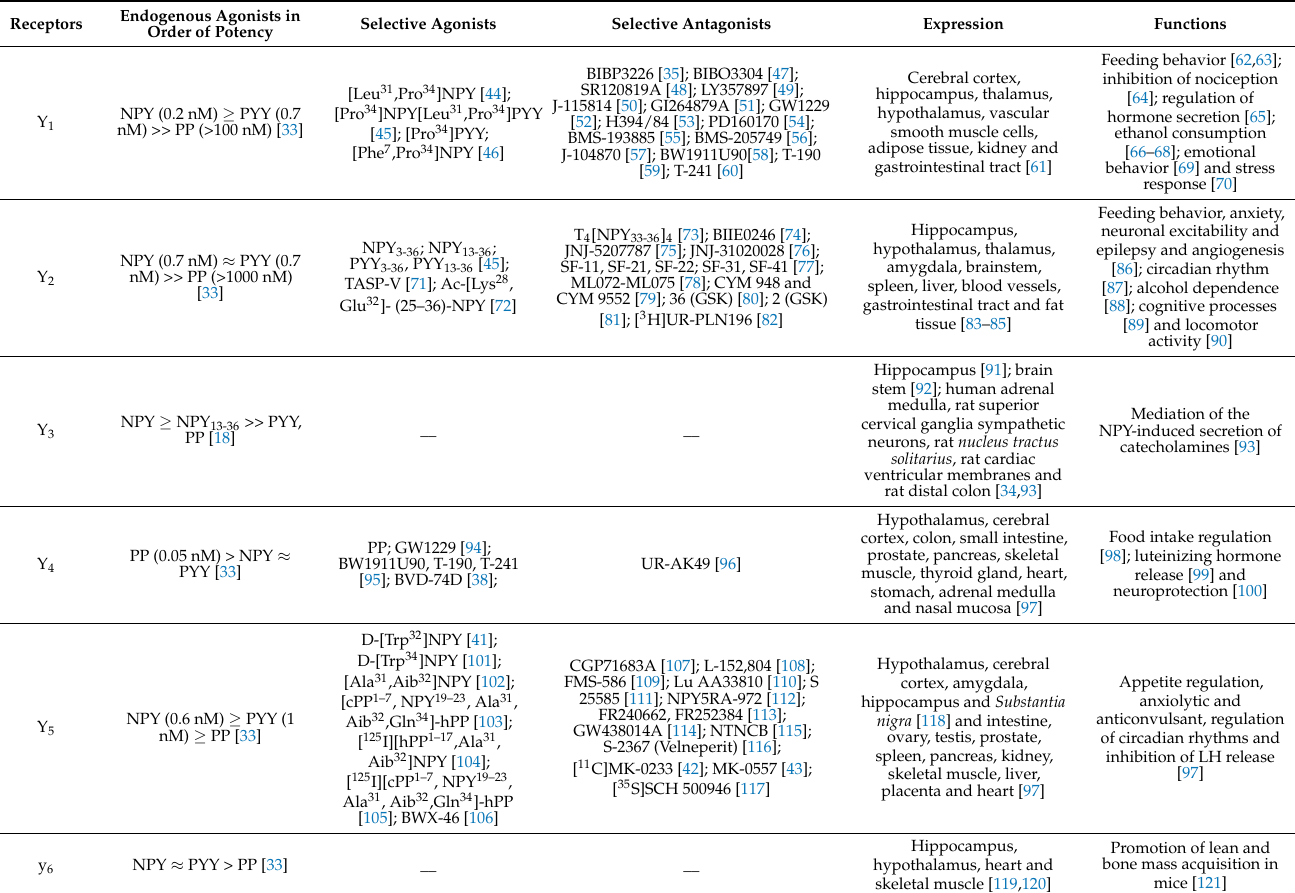
Table 2. Characterization of NPY receptor